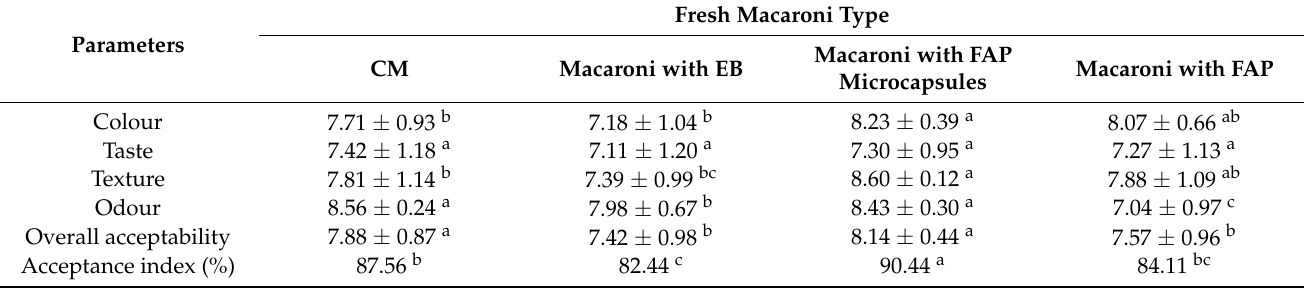
Table 5. Sensory evaluation scores of the fresh macaroni formulations enriched with free or microen- capsulated Azolla fern